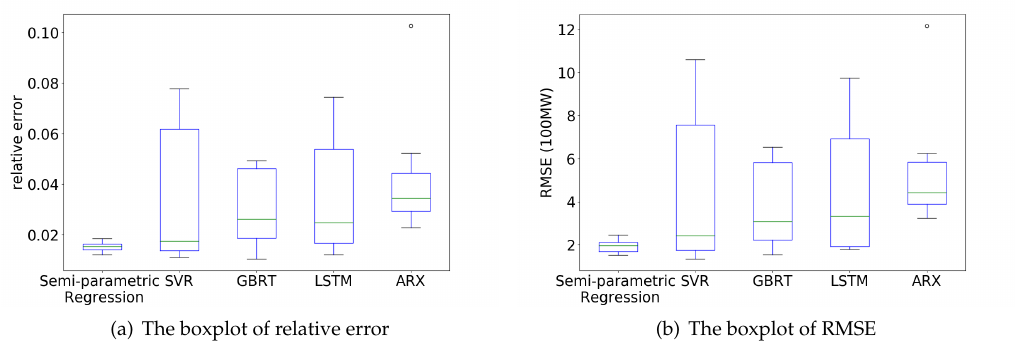
Figure 6. The boxplot of relative error and root mean square error (RMSE) for different